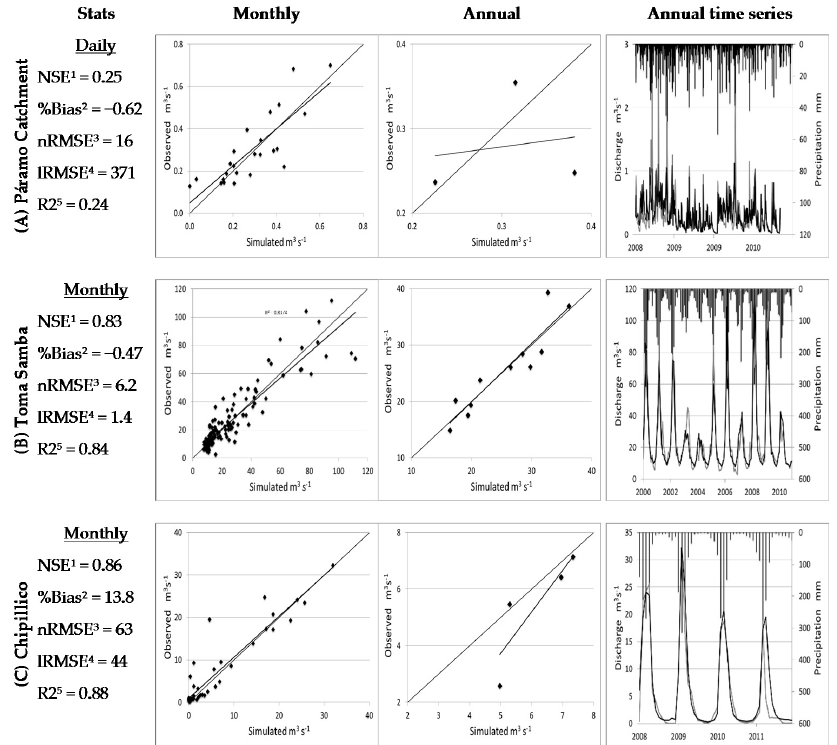
Figure 2. Monthly and annual simulated and estimated full natural flows with goodness of fit statistics at sub-basin outlets for the Piura model. The solid, dark line represents the 1:1 correspondence. 1 : Nash-Sutcliffe efficiency; 2 : percentage of Bias; 3 : normalized root mean